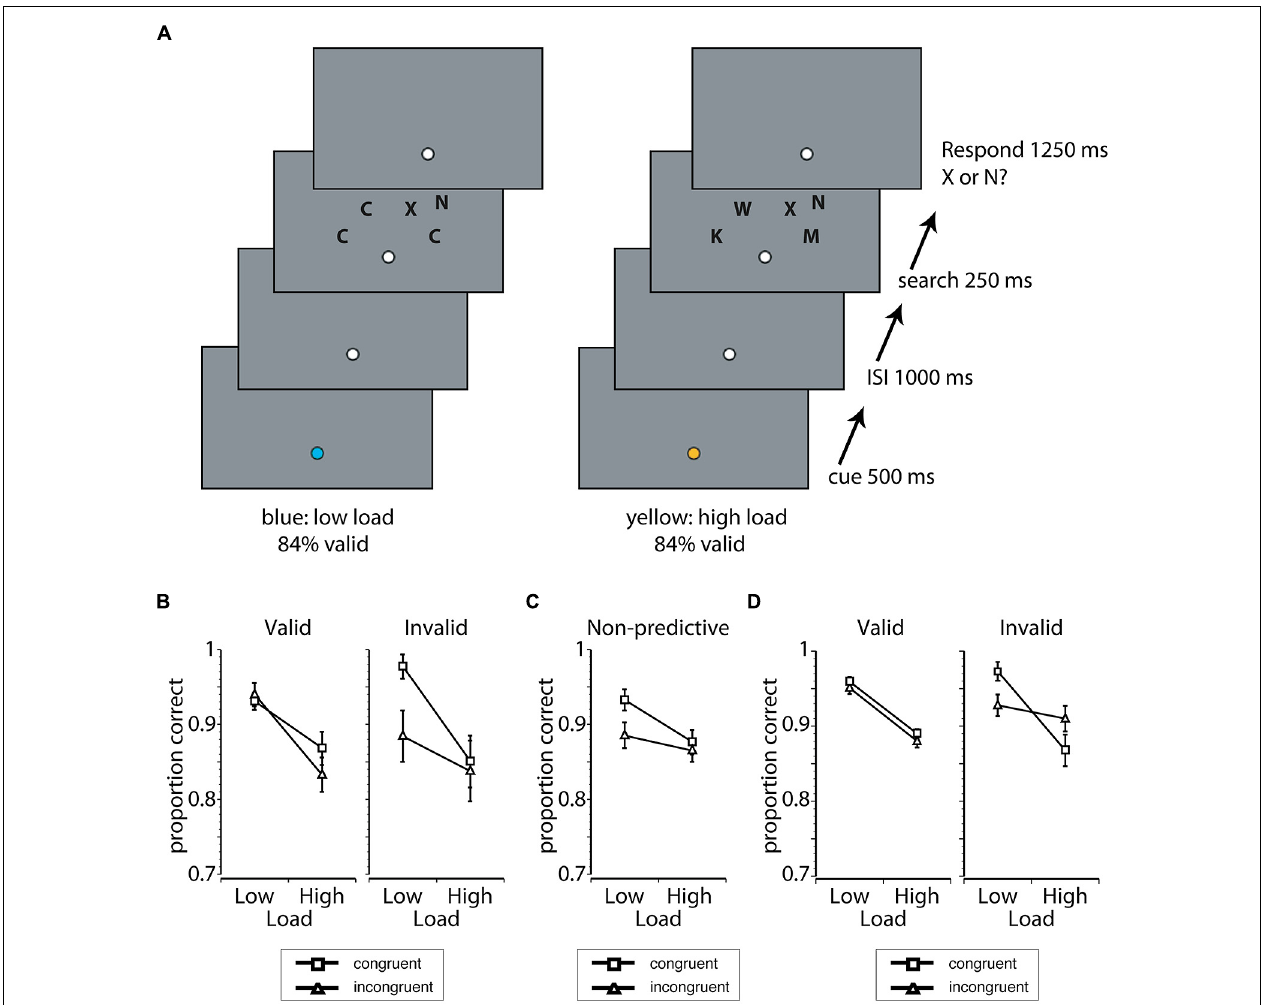
on a given trial had different identities. Behavioral interference and sensory processing of a flanker presented in an irrelevant search location, which was congruent or incongruent to the target, was used to index distraction. (B) Proportion of correct responses as a function of cue validity, load, and target-flanker congruency in Experiment 1A. Congruent trials are marked by squares, and incongruent trials are marked by triangles in all panels in this figure. Error bars represent the standard error of the mean (SEM). (C) Proportion of correct responses in Experiment 1B, the non-predictive control group. Error bars represent the SEM. (D) Proportion of correct responses in Experiment 2. Error bars represent the